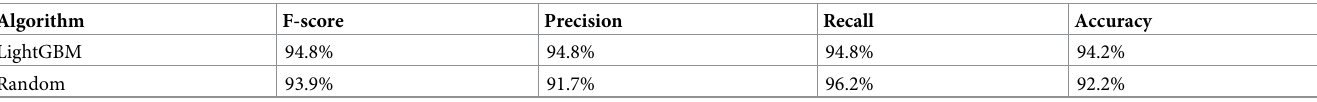
Table 4. Tech_D performance.